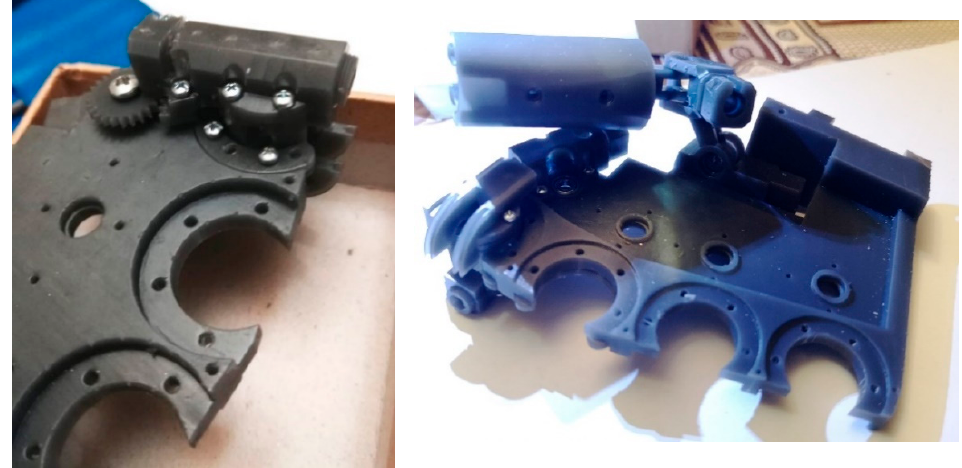
Figure 26. Components of the 2-FPRINT prototype.